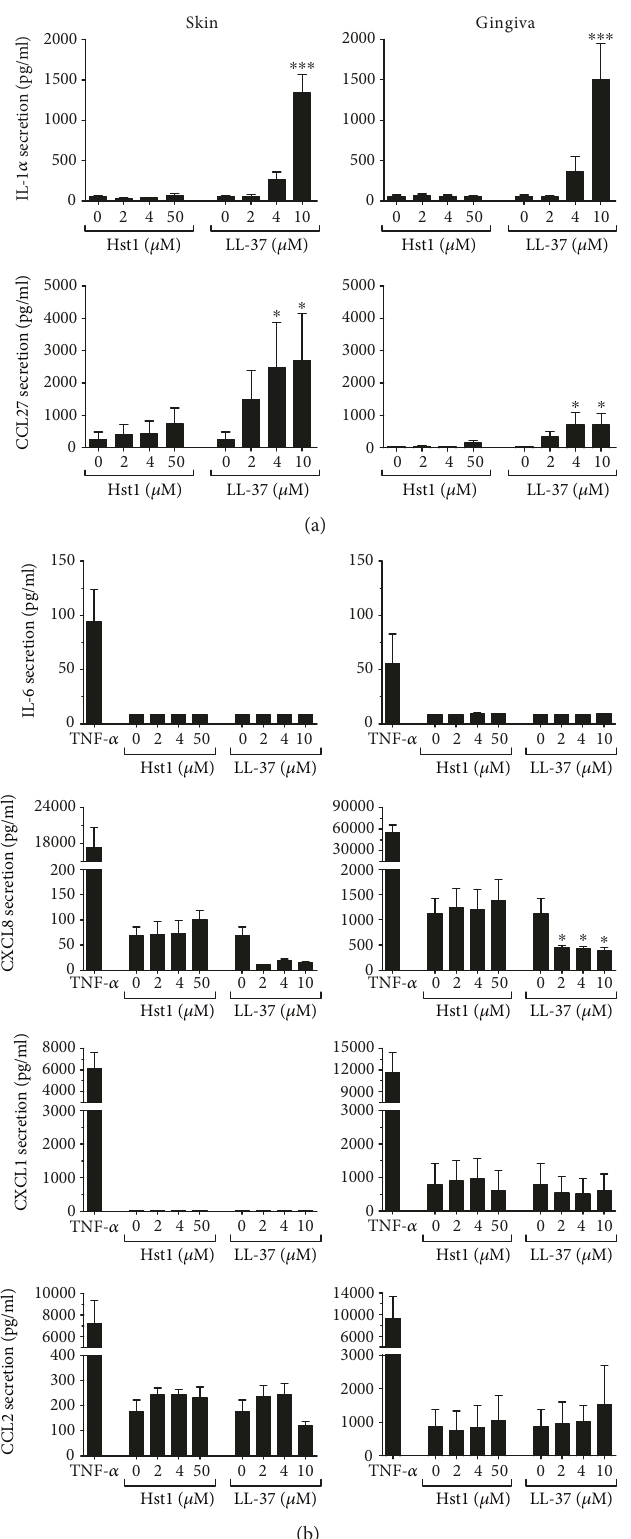
Figure 3: In fl ammatory cytokine secretion after Hst1 and LL-37 exposure. Skin or gingiva cells were exposed to either Hst1 or LL-37 for 24 hours, and cytokine secretion was assessed by ELISA. (a) IL-1 α and CCL27 secretion by keratinocyte monocultures; (b) IL-6, CCL2, CXCL1, and CXCL8 secretion by fi broblast monocultures. Each bar represents the mean ± standard error mean of 3 independent experiments each performed in duplicate. ∗ P < 0 05 and ∗∗∗ P < 0 005